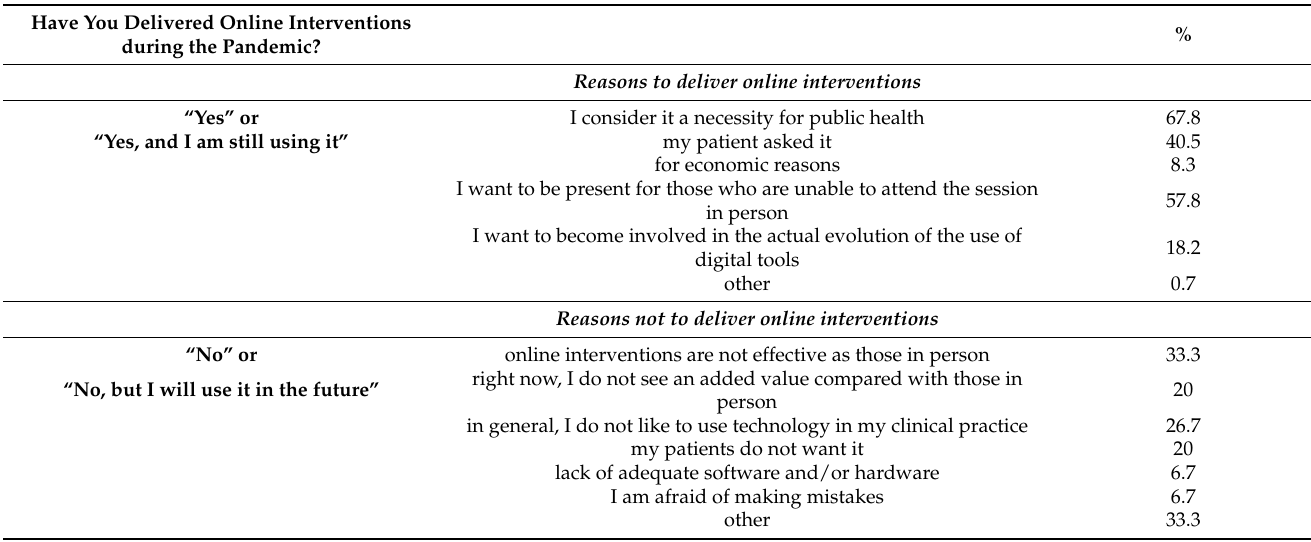
Table 4. Data on reasons whether to deliver online interventions during the COVID-19 pandemic (starting from March